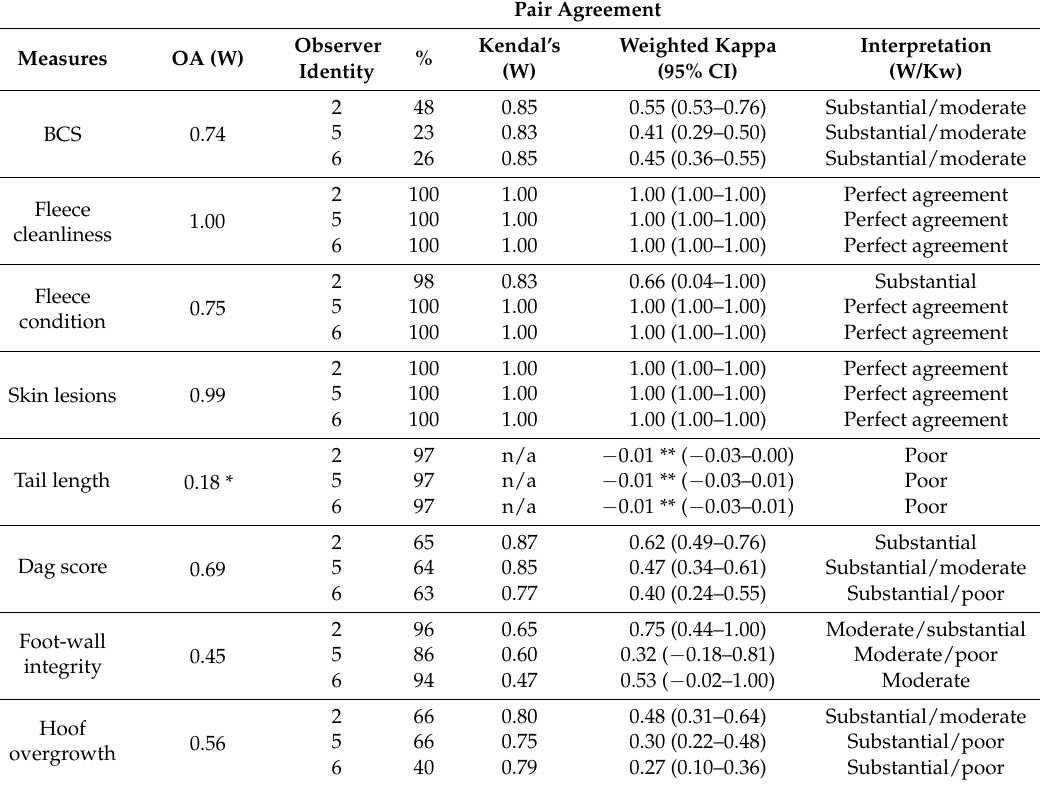
Table 4. Overall observer agreement (OA), percentage of agreement (%) and pair agreement at mid-lactation.